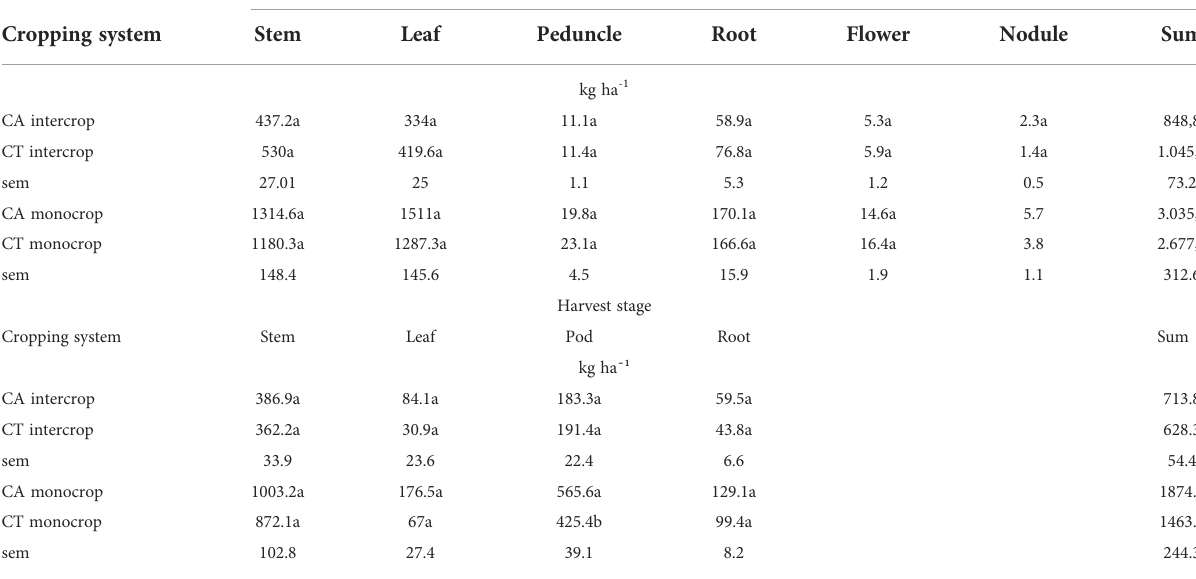
TABLE 3 Cowpea biomass accumulation in different plant parts at fl owering and harvest stage as affected by cropping